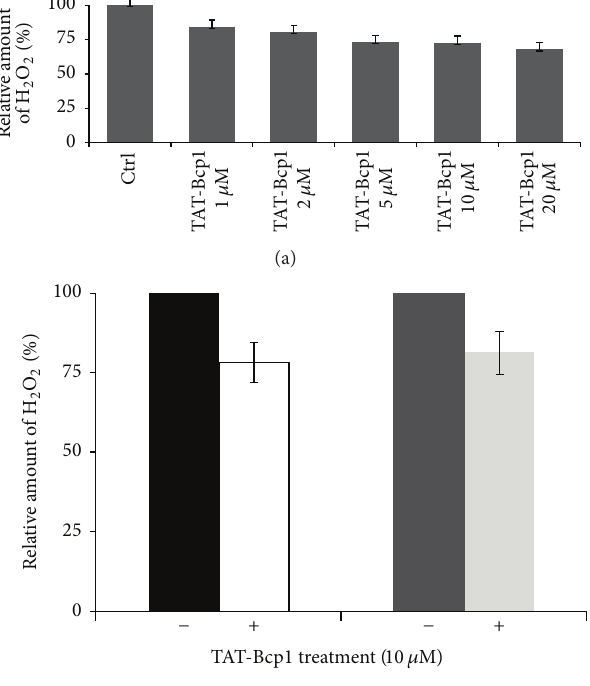
Figure 6: Effect of TAT-Bcp1 on H 2 O 2 levels in H9c2 cells. (a) Dose-dependent effect of TAT-Bcp1 (1–20 𝜇 M) on the H 2 O 2 content in H9c2 cells grown under physiological conditions. (b) Effect of the TAT-Bcp1 pretreatment on unstressed and H 2 O 2 -stressed cells. Unstressed cells (dark bars); H 2 O 2 -stressed cells (light